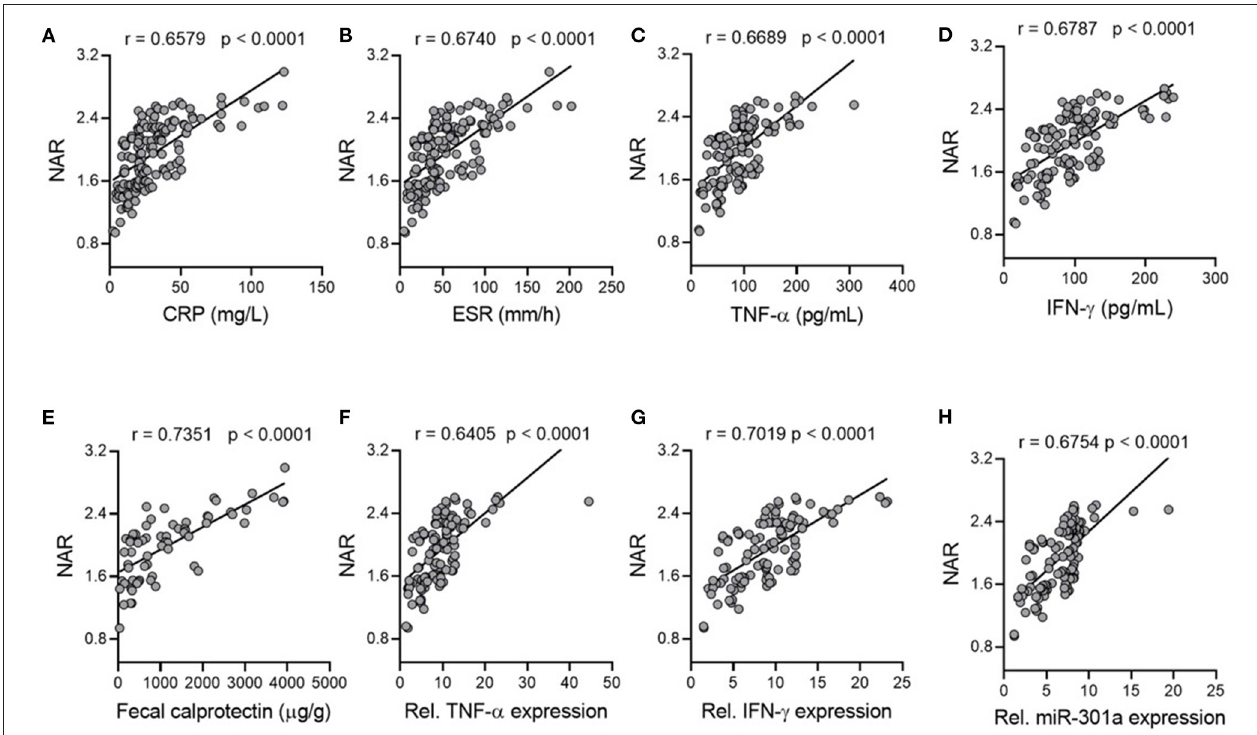
FIGURE 3 | Associations of NAR with inflammatory load in patients with UC. Correlation of NAR with (A) C-reactive protein (CRP) and (B) erythrocyte sedimentation rate (ESR). (A,B) , n = 146. Serum (C) TNF- α and (D) IFN- γ protein levels were positively associated with NAR. (C,D) , n = 122. (E) Fecal calprotectin levels ( n = 66), mucosal (F) TNF- α , (G) IFN- γ , and (H) miR-301a relative expression levels positively correlated with NAR. (F–H) , UC, n = 110; Controls, n = 75 (for gene relative expression